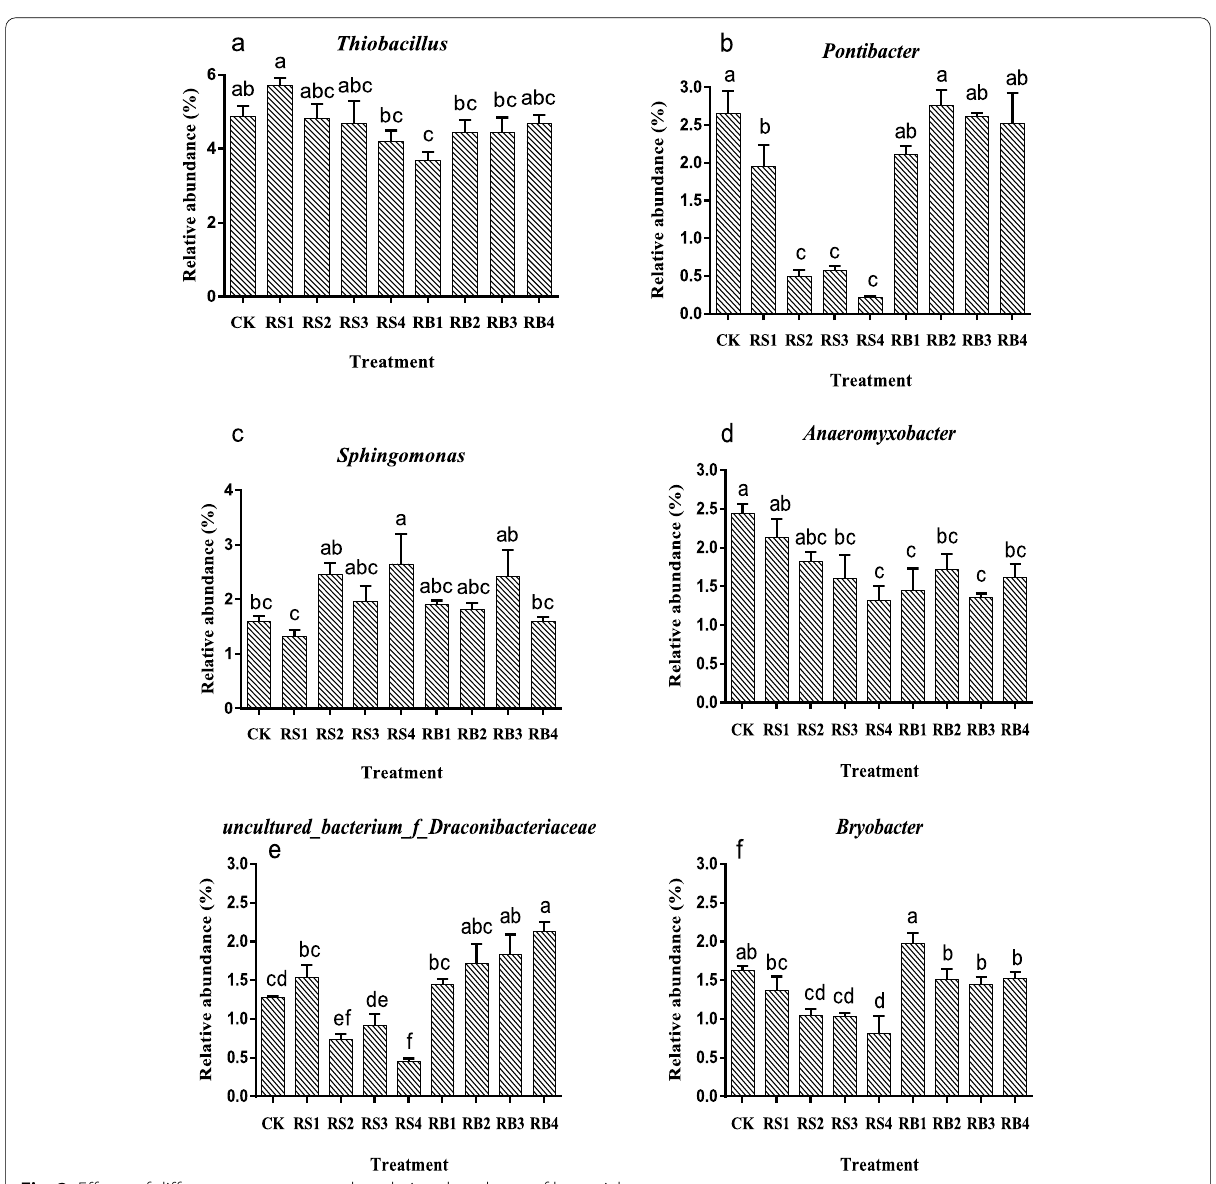
Fig. 2 Effects of different treatments on the relative abundance of bacterial